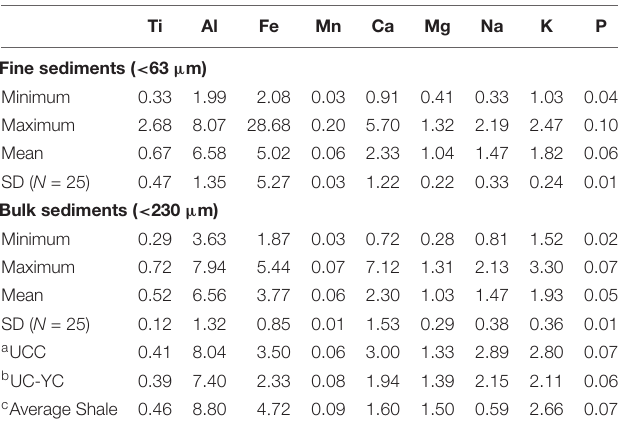
TABLE 1 | Summary statistics of major elements (%) in surface sediments along the west coast of Hainan Island, the Gulf of